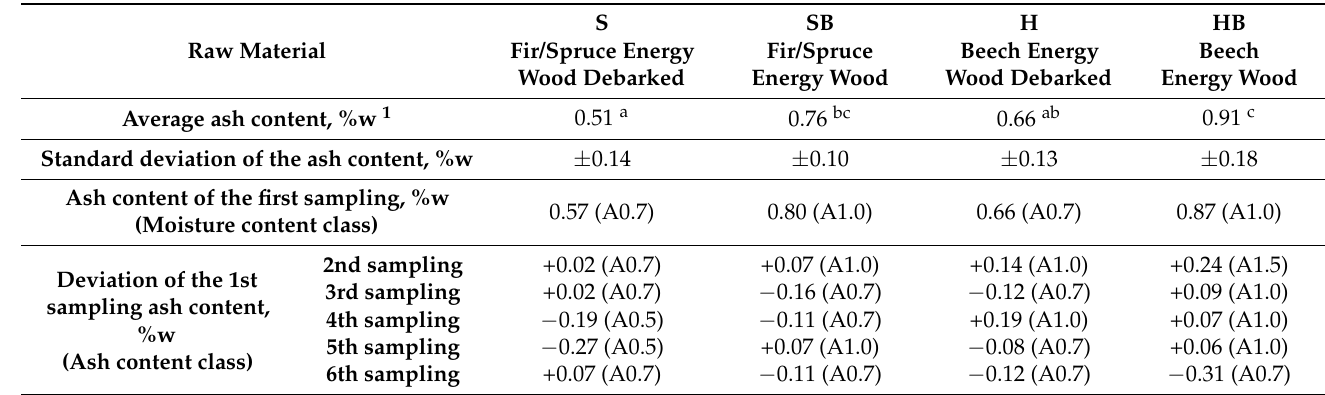
Table 2. Results of the ash content analyses.